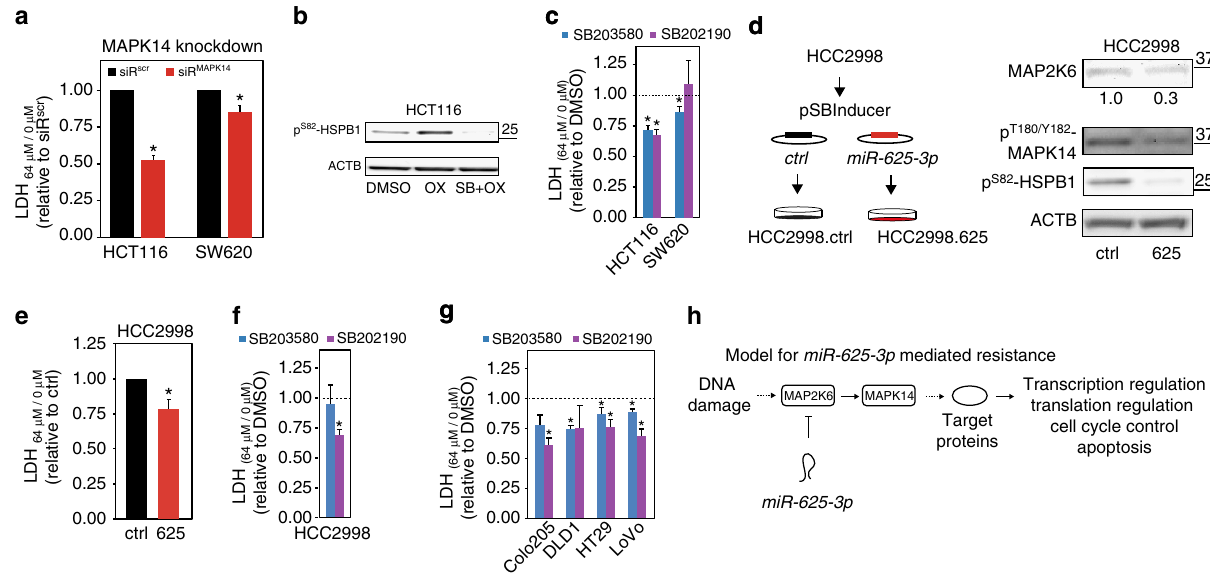
Figure 7 | Inhibition of MAPK14 induces oxaliplatin resistance in CRC cells. ( a ) MAPK14 was specifically depleted from HCT116 and SW620 cells by transfection of a pool of MAPK14 targeting siRNAs (siR MAPK14 ) 48h before being treated with 64 m M oxPt for 48h (or left unexposed; see Supplementary Fig. 9 for knockdown efficiencies). The impact on cell death (64 m M/0 m M) was determined by LDH and are displayed relative to cells transfected with a scrambled siRNA (siR scr , set to 1). Mean ± s.e.m. from at least n ¼ 4 experiments with ‘*’ indicating a significant reduction in oxPt-induced cells death compared with siR scr transfected cells ( P r 0.05, t -test). ( b ) A phospho-specific western blot versus the MAPK14/MAPKAPK2 substrate Ser82-HSPB1 was applied to show increased MAPK14 activity after oxPt treatment and the inhibitory effect of 10 m M SB203580 on this activity. ( c ) HCT116 and SW620 cells were treated for 1h with MAPK11/14 inhibitors SB203580 (10 m M, blue) or SB202190 (5 m M, purple), then exposed to 64 m M oxPt (or left unexposed) for 48h before the increase in cell death (64 m M/0 m M) was determined by LDH. Presented relative to cells not treated with inhibitor (DMSO treated; mean ± s.e.m. from at least n ¼ 4 experiments with ‘*’ indicating a significant reduction in oxPt-induced death compared with DMSO-treated cells, P r 0.05, t -test). ( d ) Stable, inducible expression of miR-625-3p was generated using pSBInducer transposition in HCC2998 CRC cells (left). Phospho-specific western blot for MAP2K6 and MAPK14 activity 48h after DOX induction of HCC2998.ctrl and HCC2998.625 cells (right). ( e ) HCC2298.ctrl and HCC2998.625 cells DOX-induced for 48h, then treated (or left untreated) with 64 m M oxPt for 48h before the increase in cell death (64 m M/0 m M) was determined by LDH. Results are displayed relative to control cells (set to 1; mean ± s.e.m. from n ¼ 3 experiments; * P r 0.05, t -test). ( f , g ) HCC2998, Colo205, DLD1, HT29 and LoVo CRC cells were treated for 1h with MAPK11/14 inhibitors SB203580 (10 m M, blue) or SB202190 (5 m M, purple) then exposed to 64 m M oxPt (or left unexposed) for 48h before the increase in cell death (64 m M/0 m M) was determined by LDH. Displayed relative showing how miR-625-3p mediated downregulation of MAP2K6 could modulate response to oxPt by abrogating MAPK14 stress-induced signalling. In the canonical model MAP2K6 in complex with MAP2K3 phosphorylates and activates MAPK14, which in turn—directly or indirectly via substrate kinases such as MAPKAPK2—activates a diverse number of target proteins central to stress-induced transcription, translation, cell cycle control and